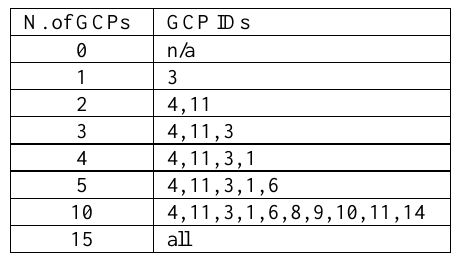
Table 1. Number of GCP used for the 8 model orientation tests